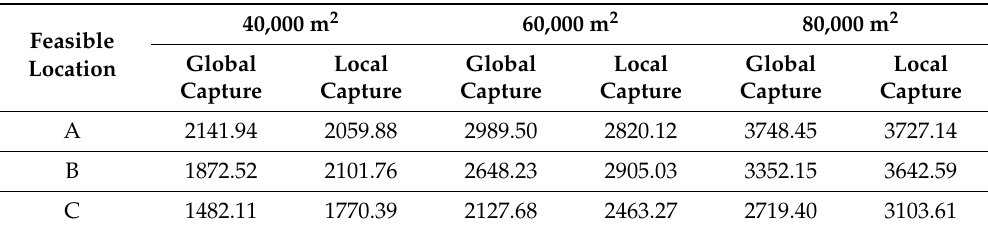
Table 4. Global and local captures for di ff erent feasible